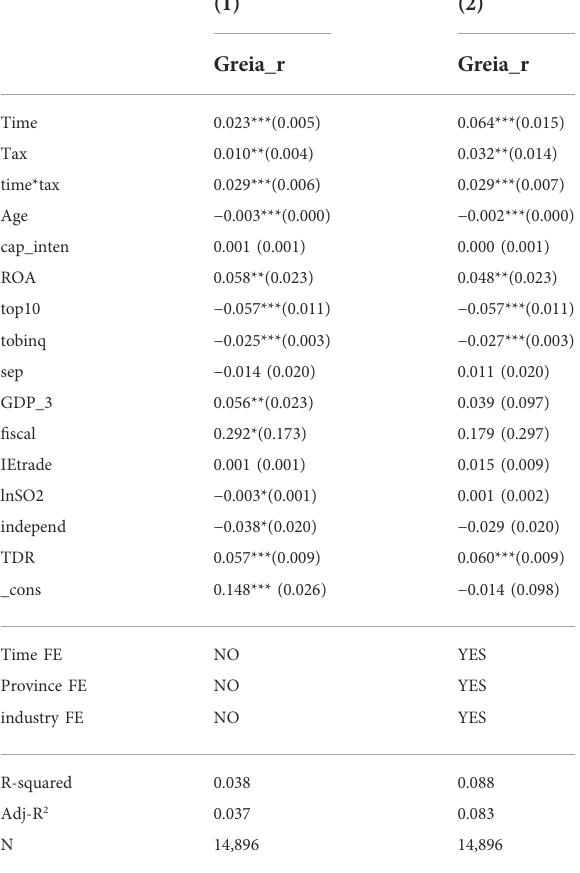
TABLE 9 Robustness test regression results: Alternative explanatory